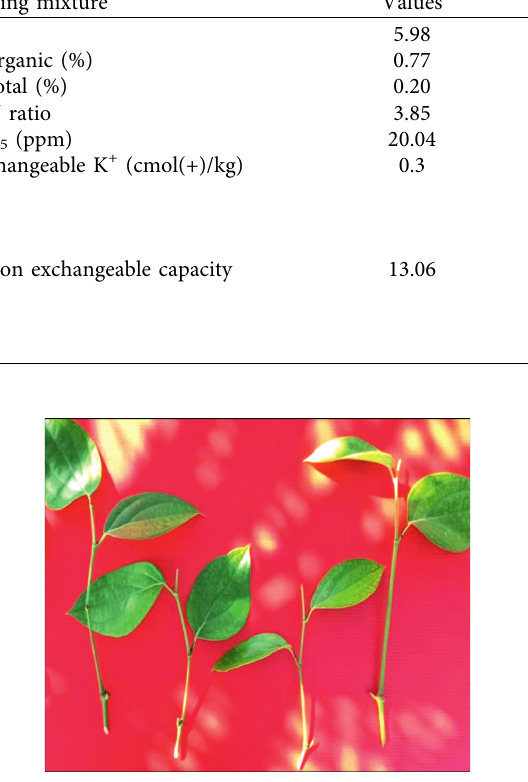
Table 1: Chemical characteristics of the potting mixture and nutrient content of the fertilizer. Potting mixture